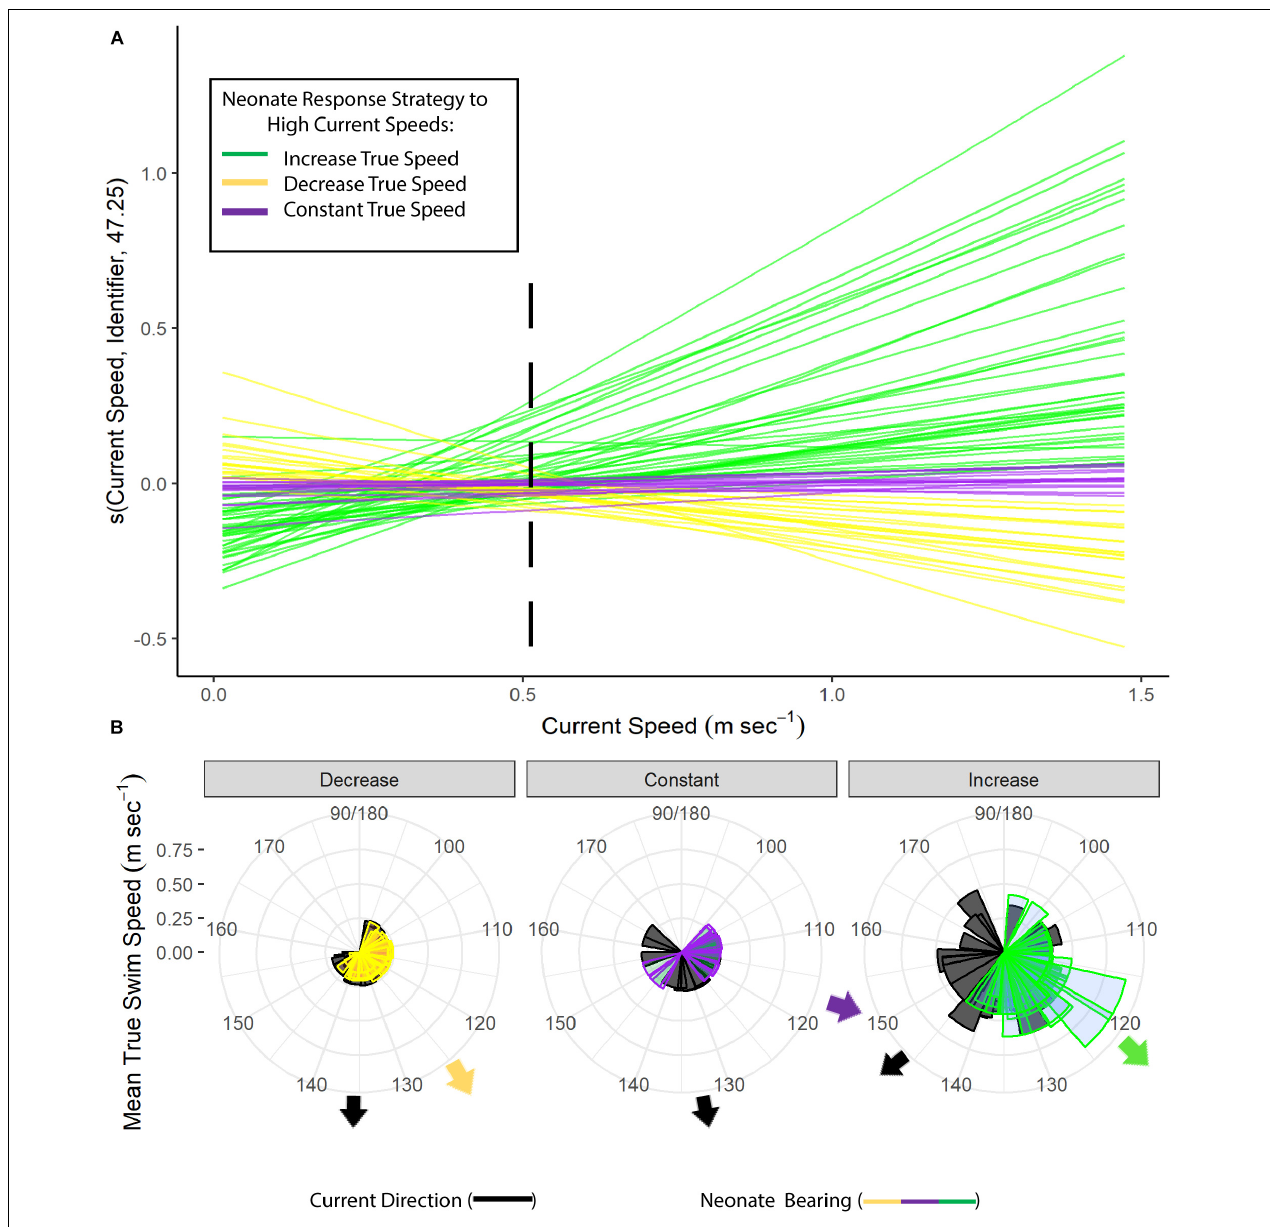
FIGURE 4 | (A) Generalized additive mixed model (GAMM) smoothing curve for current speed (m s − 1 ) as a function of neonate true swimming speeds for 2016 and 2018, with an estimated random departure from the mean true speed trajectory for each neonate represented by colored lines and k = 5 basis functions. Each color represents the response strategy of each neonate to high current speed conditions ( > 0.5 m s − 1 ): mean increase in true speed (green), mean decrease in true speed (yellow), or no change in mean true speed (purple). The threshold for high current speed conditions is shown with a black dashed line. (B) Rose plots for the frequency of mean neonate true swimming speed plotted by neonate raw track bearing or current direction. Colors represent neonate raw track bearing for each swimming speed response strategy in currents greater than 0.5 m s − 1 (decrease/yellow, constant/purple, increase/green), and black represents current direction for current speeds greater than 0.5 m s − 1